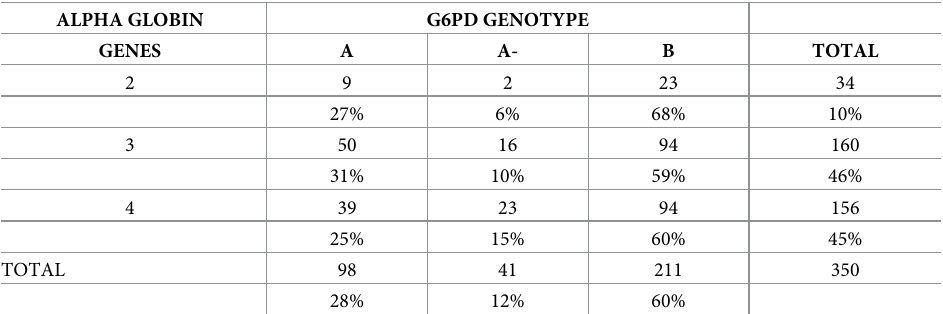
Table 3. Prevalence and assortment of hemoglobin genotype α -globin gene numbers and G6PD genotypes.